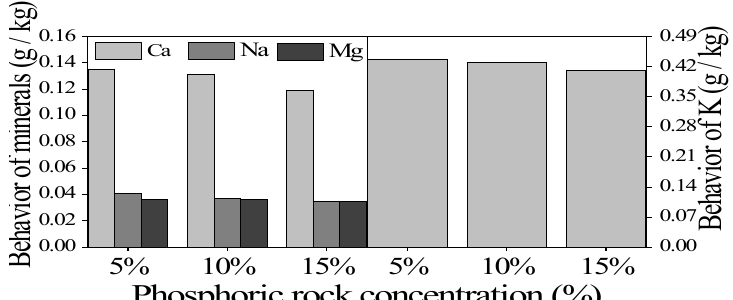
Fig. 5 Variation of the behavior of minerals at different PR